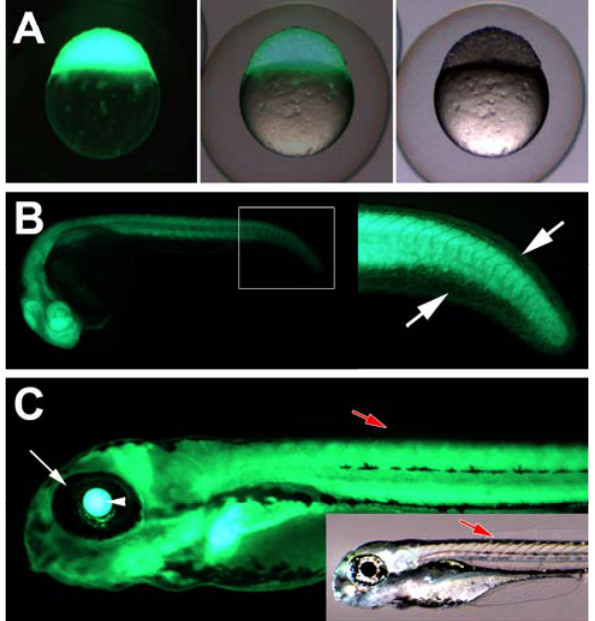
FIGURE 1. Expression of Tg( ef1- α :EGFP ) nt during early development. (A) Maternal expression of the ef1- α :EGFP transgene through the blastula stage at 3 hpf. Fluorescent image on far left, brightfield image on far right, merge in the center. (B) Fluorescent image of a 26-hpf embryo (left panel) demonstrates broad expression of the ef1- α :EGFP transgene in the body. The boxed region is magnified to the right to show EGFP expression in the developing fin fold (arrows).